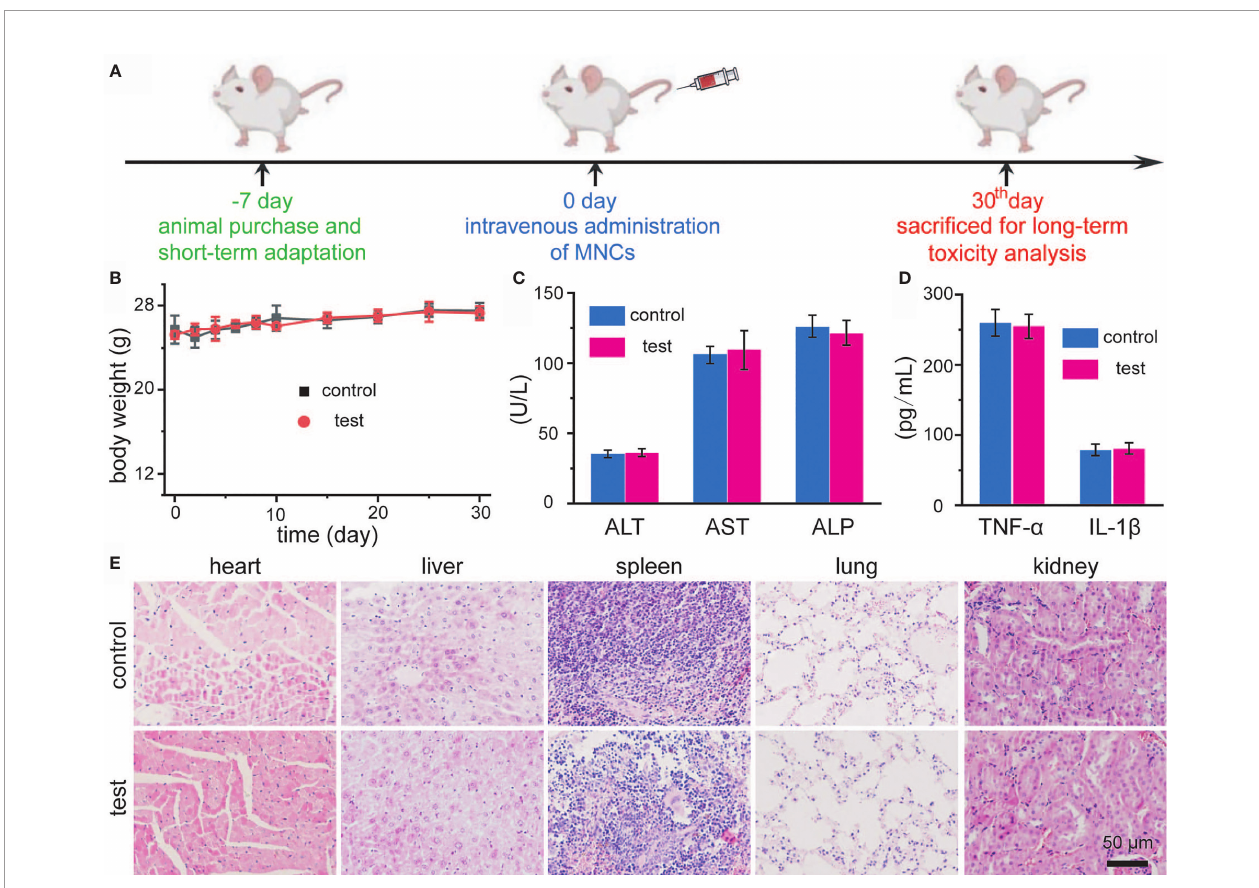
FIGURE 6 | Schematic illustration of in vivo toxicity evaluation of MNCs (A) . Body-weight changes of Balb/c mice after intravenous injection of MNCs (B) . Serum levels of ALT, AST, and ALP in mice (C) . Serum levels of TNF- a and IL- b in mice (D) . H&E staining images of mouse main exposed organs after different treatments (E)